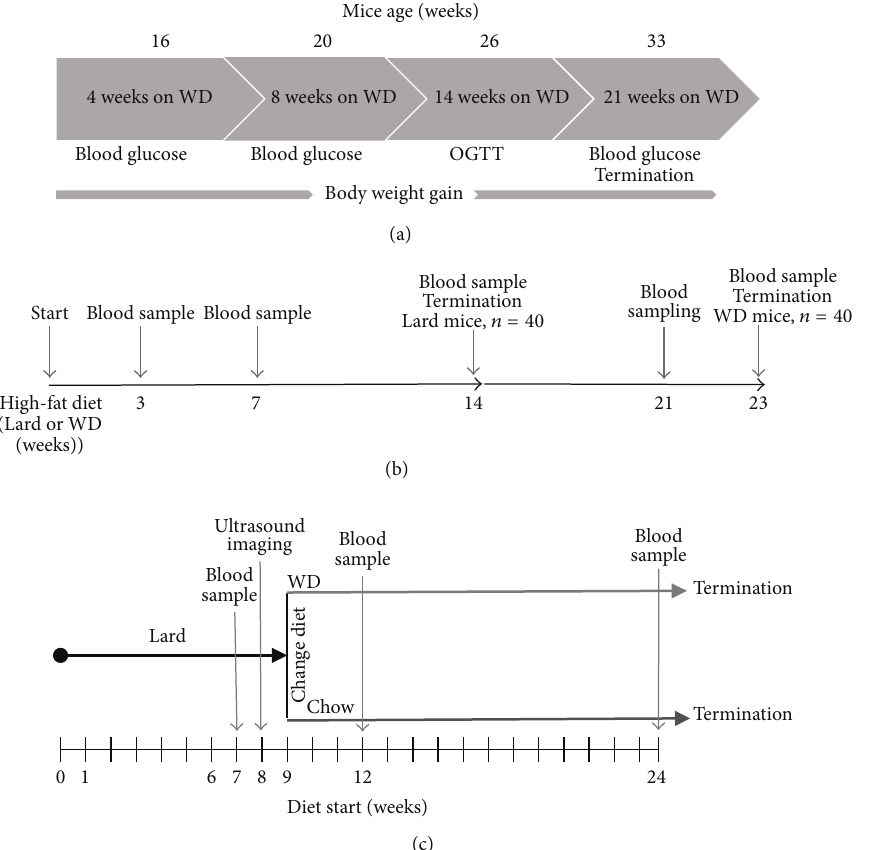
Figure 1: Study design for the characterization of the diabetic phenotype of the GK +/− ApoE −/− and the ApoE −/− mice on Western diet (WD) (a), study design for the atheroprogression study (b), and atheroregression study (c).